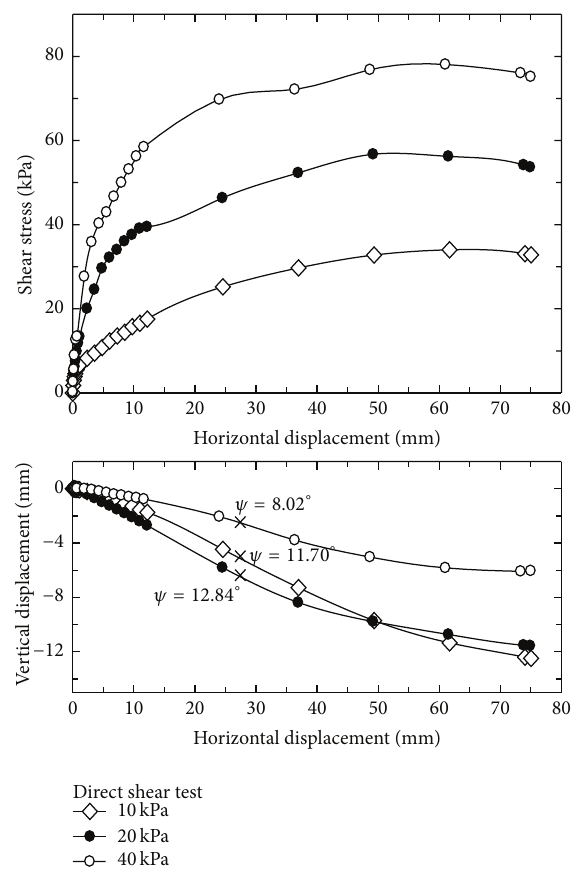
Figure 4: DST test results of